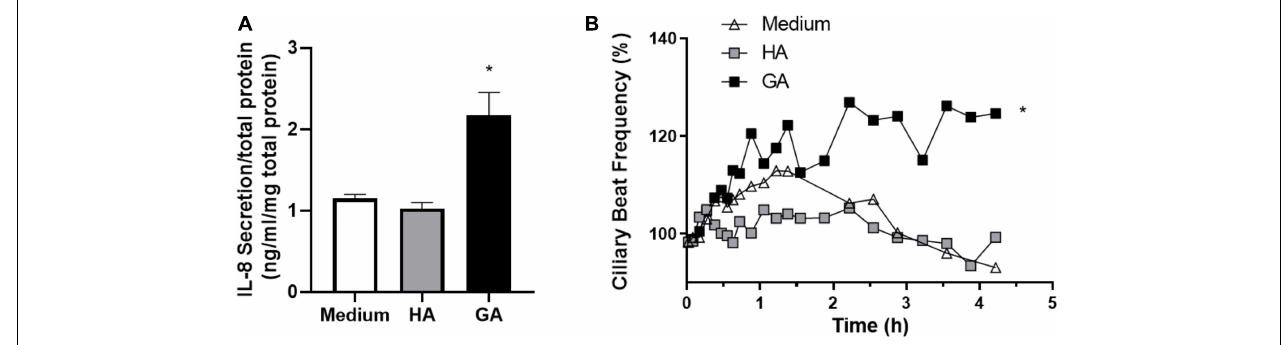
FIGURE 4 | GA increased IL-8 secretion and CBF in human adenoid epithelial cell cultures. (A) Human primary adenoid epithelial ciliated cell cultures were incubated with culture medium, HA (2 mg/mL), or GA (2 mg/mL) for 3 h. GA increased the statistical significance of IL-8 secretion with respect to HA and medium. Values are expressed as ng/mL of IL-8 corrected by mg of protein in primary culture. * p < 0.05. (B) Time-course changes in CBF of non-CF human adenoid ciliated cell culture treated with GA ( (cid:4) , 2 mg/mL), HA ( (cid:3) , 2 mg/mL), and control solution ( (cid:52) , medium). The most significant effect upon CBF was observed after 2–4 h of incubation with GA. n = 4–5 cultures were used for each experimental point included in the Il-8 secretion experiments and the time course changes on CBF exposed to medium, HA, and GA.